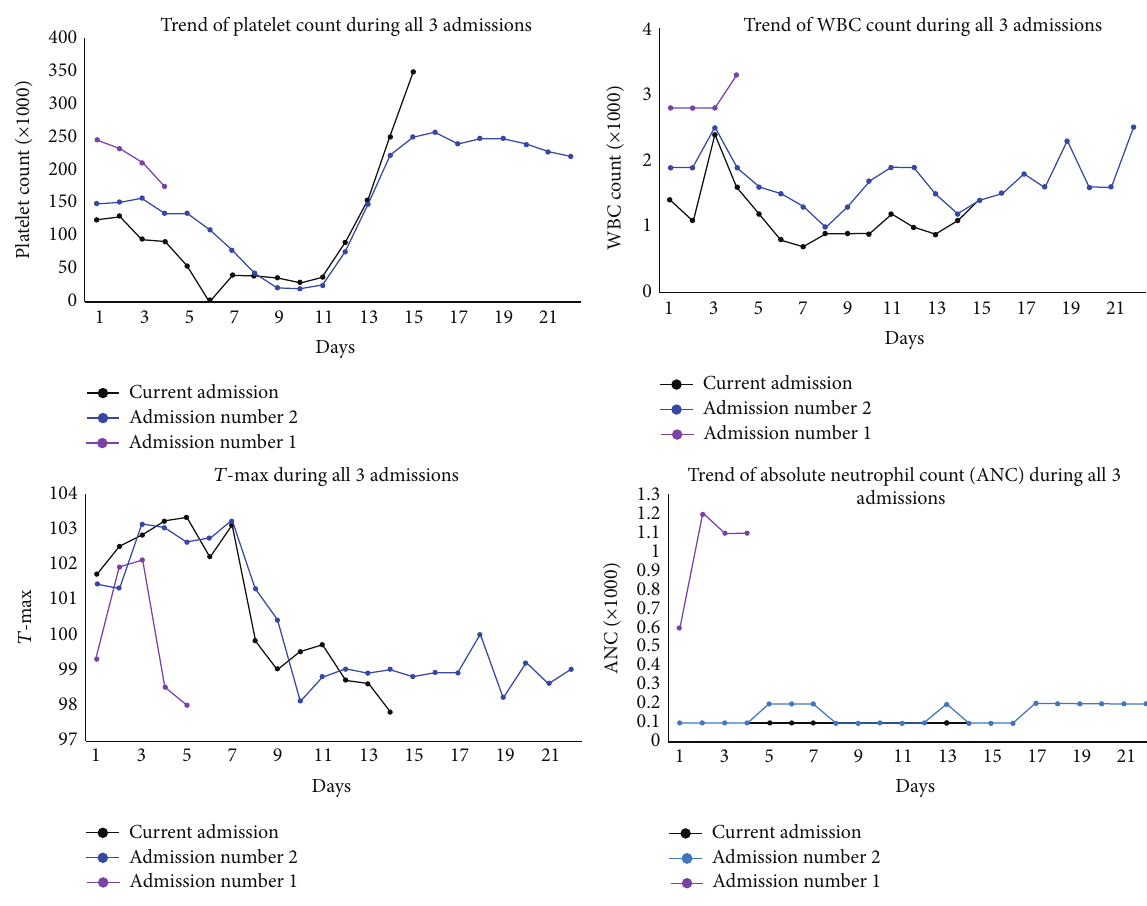
Figure 1: Graph of trend for platelets, temperature, and WBC and ANC